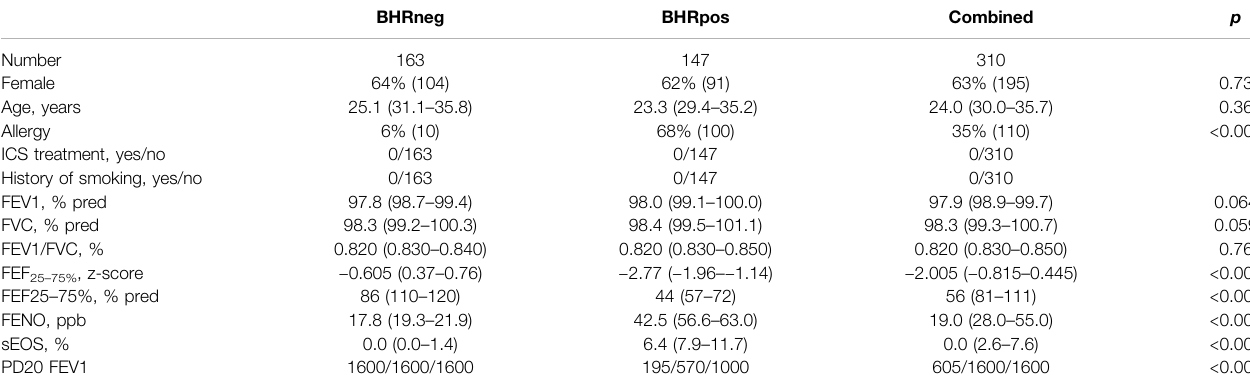
TABLE 1 | Subject characteristics in positive and negative bronchial hyperreactivity (BHR) groups.